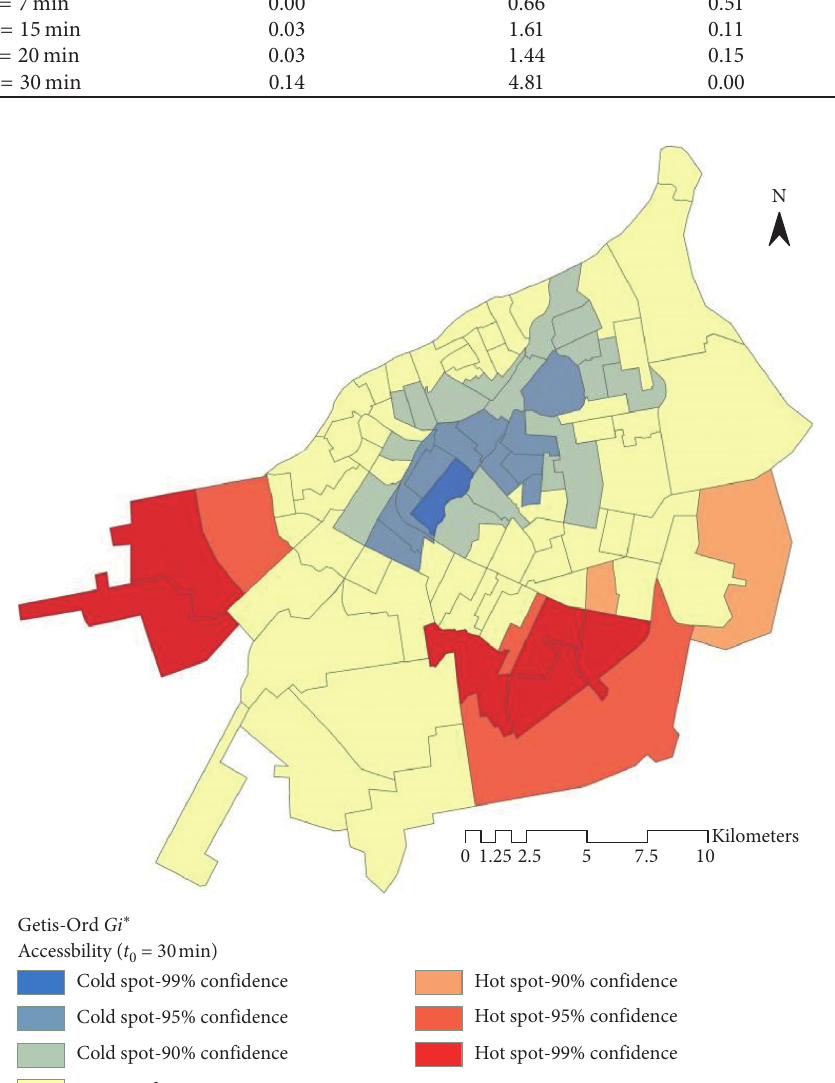
Figure 4: Hot spot analysis (Getis-Ord Gi ∗ ) of accessibility d ( t